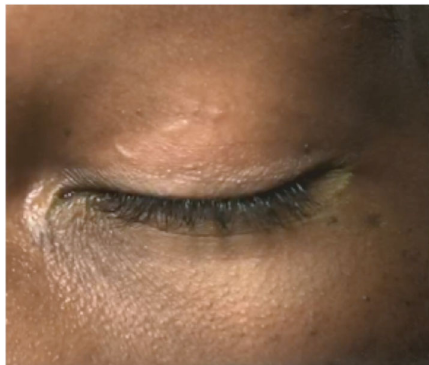
Figure 1: External photograph of left periorbital region which demonstrates a thin, serpentine lesion of the left upper eyelid near the eyelid